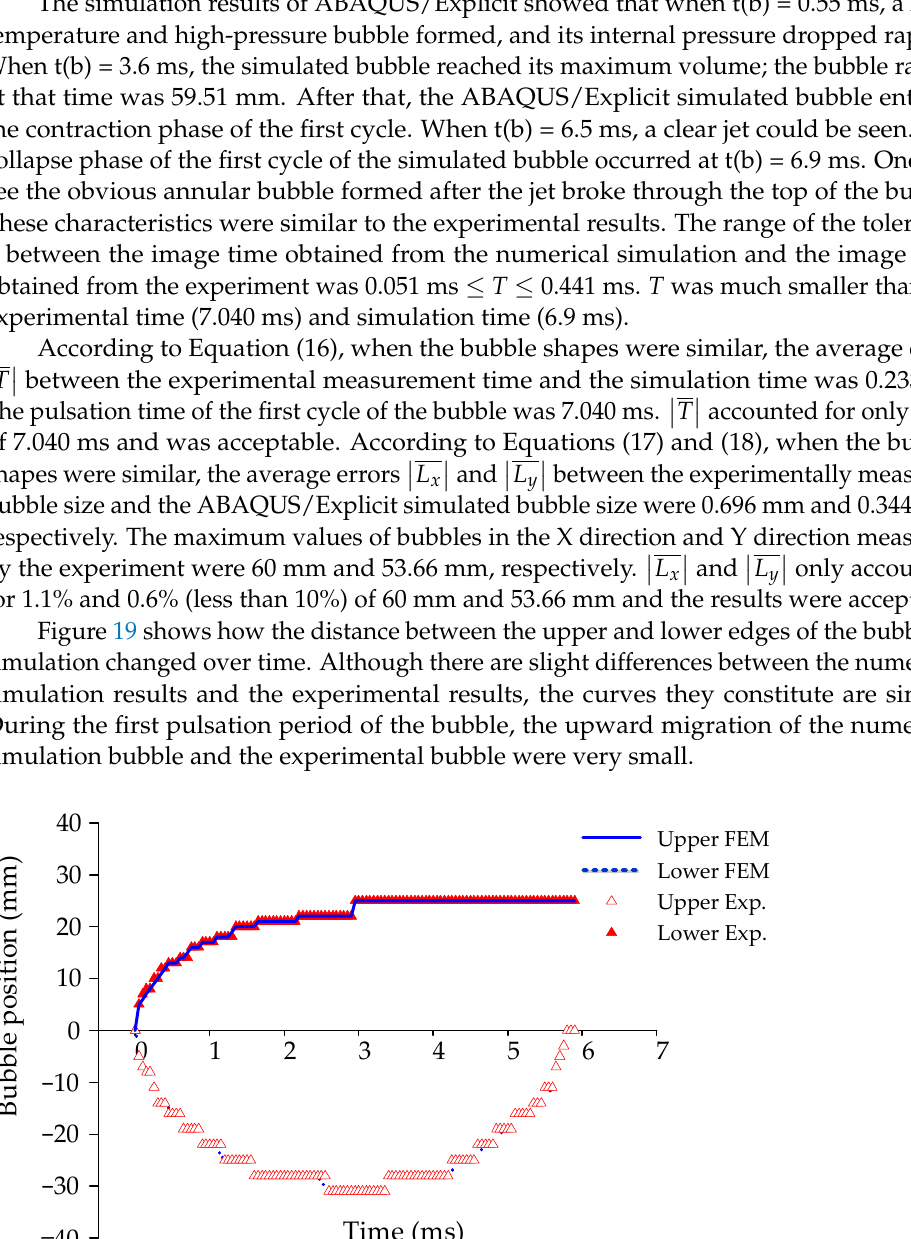
Figure 20. Simulated bubble motion during the collapse phase at: ( a ) t = 6.55 ms; ( b ) t = 6.60 ms; ( c ) t = 6.70 ms; ( d ) t = 6.75 ms; ( e ) t = 6.80 ms; and ( f ) t = 6.90 ms.